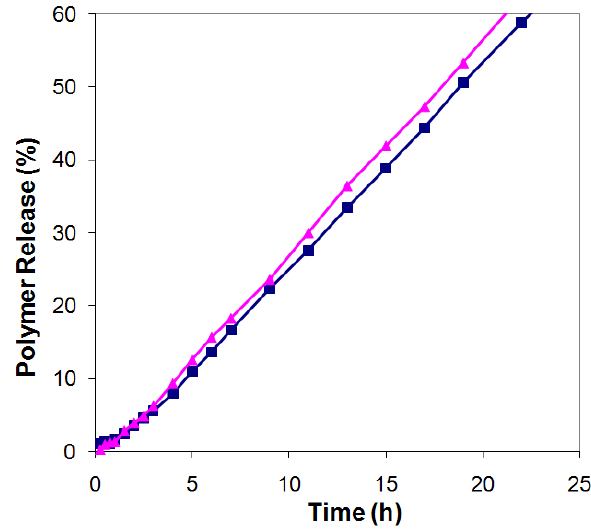
Figure 4. Release profiles up to 60% released polymer, for the low molecular fraction (triangles) and high molecular weight fraction (squares) of tablets from HPMC